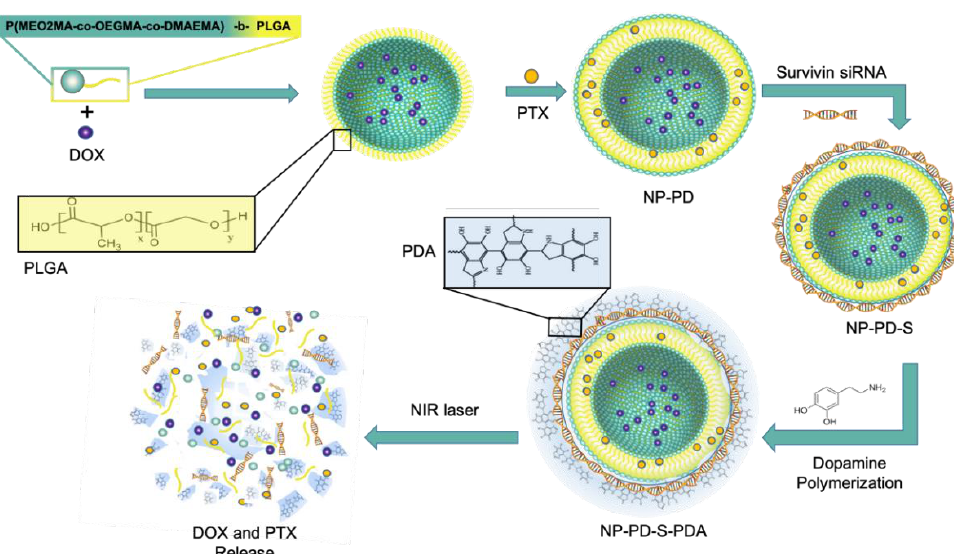
Figure 8. Schematic representation of constructing P(MEO2MA-co-OEGMA-co-DMAEMA)-b-PLGA based NP which delivers doxorubicin (DOX) and paclitaxel (PTX) simultaneously (NP-PD). The surface absorbance of small interfering RNAs against survival (NP-PD-S), formed a nanostructure to be finally coated by a self-polymerized dopamine (PDA) film (NP-PD-S-PDA). Drug release took place following near infra-red (NIR) laser-triggered NP collapse.